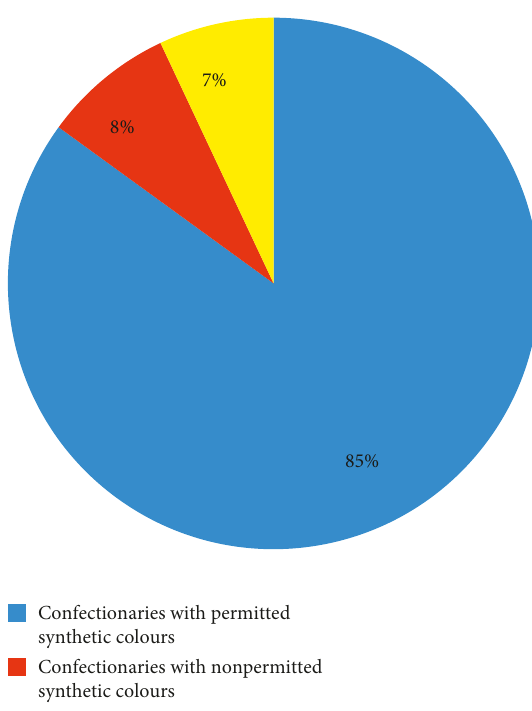
Figure 2: Colour distribution of the confectionaries collected from Jaffna district as